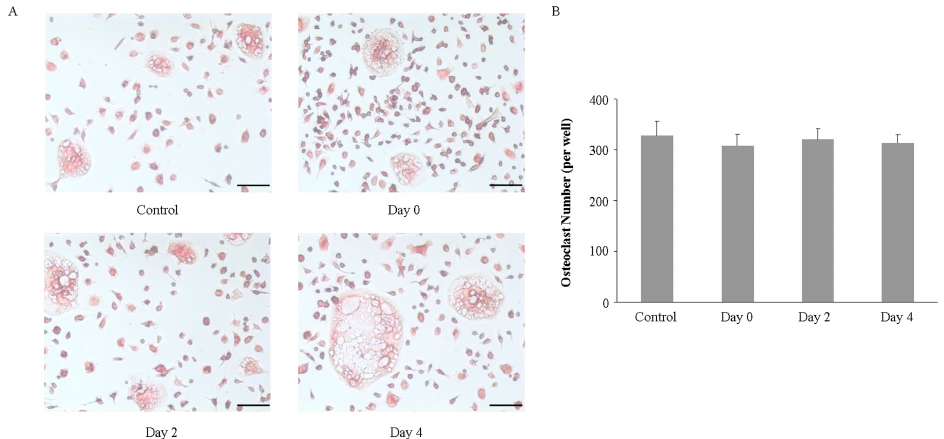
results indicated that imipramine inhibited MV-induced osteoclast formation by blocking MV generation, thereby reducing the signaling required for osteoclast differentiation and activation.